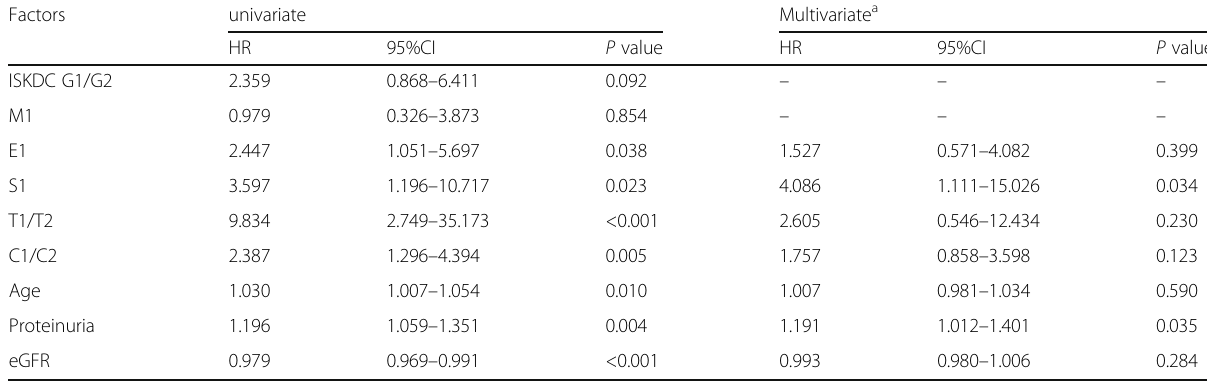
Table 5 Cox model analysis for renal endpoints